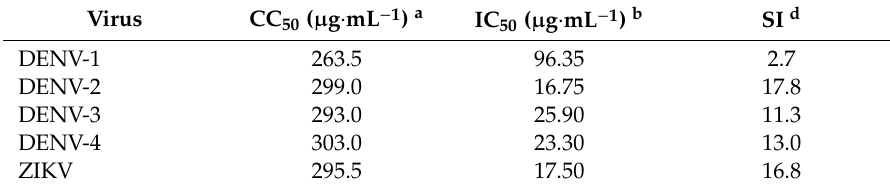
Table 1. Cytotoxicity and antiviral activity of D. apetalum